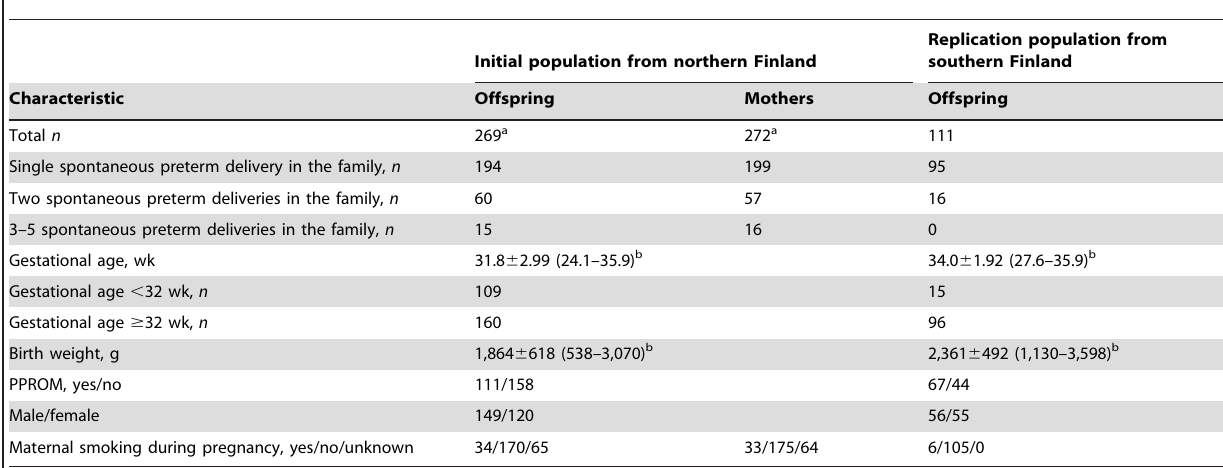
Table 1. Clinical characteristics of the case study populations of spontaneous preterm